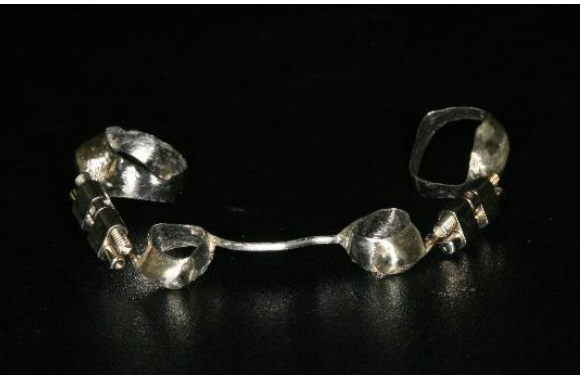
Figure 1. Photography of the custom-manufactured dental-anchored distractor. Surgically, the cortectomy is performed between the lower premolars, with slight de- viation to preserve the continuity of the inferior alveolar neurovascular bundle.